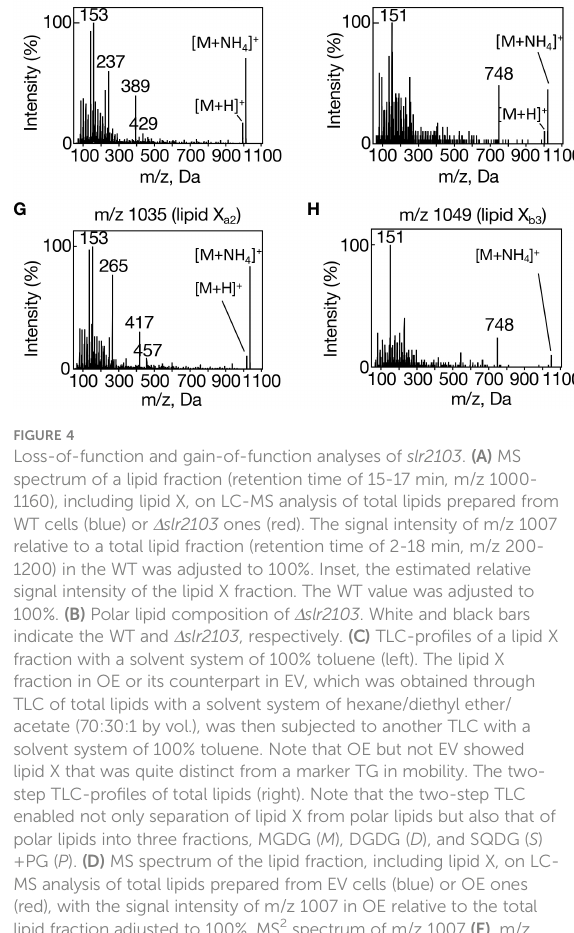
(Supplementary Figure 6C, right). In view of the same retention time range and higher signal intensities in D slr2103 than in the WT, these three ions, m/z 748, 766, and 788, would be derived from the same analyte that represents the acyl-acceptor substrate of Slr2103.